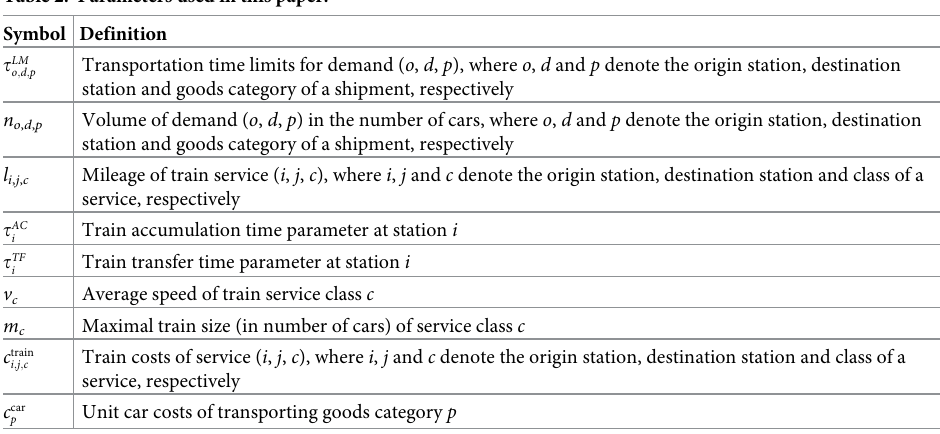
Table 2. Parameters used in this paper.